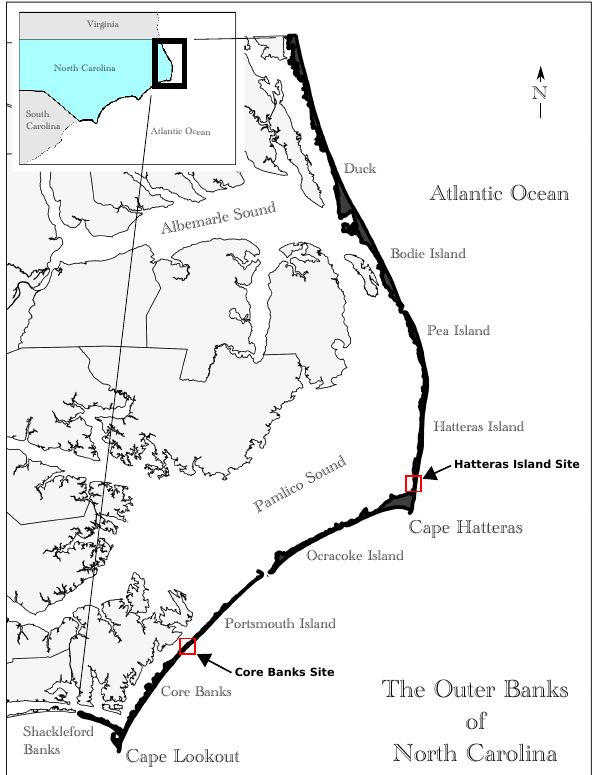
Figure 1. Location of the Core Banks and Hatteras Island Study sites along the North Carolina Outer